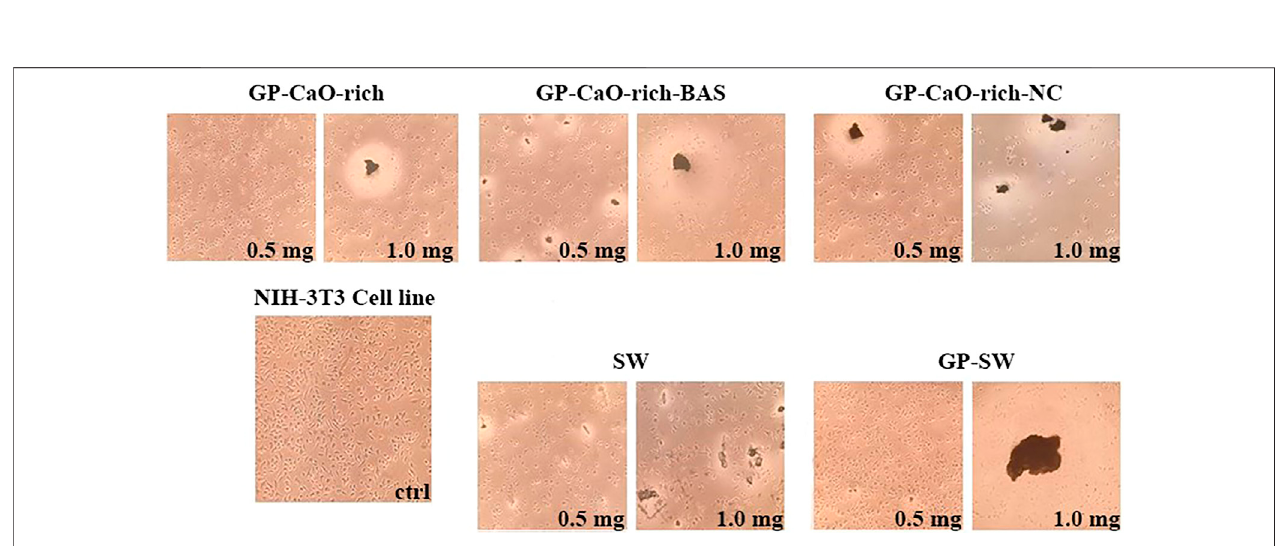
FIGURE 12 | Cytotoxicity image results of the tests performed on samples: GP-CaO-rich, GP-CaO-rich-NC, GP-CaO-rich-BAS, SW, and GP-SW.